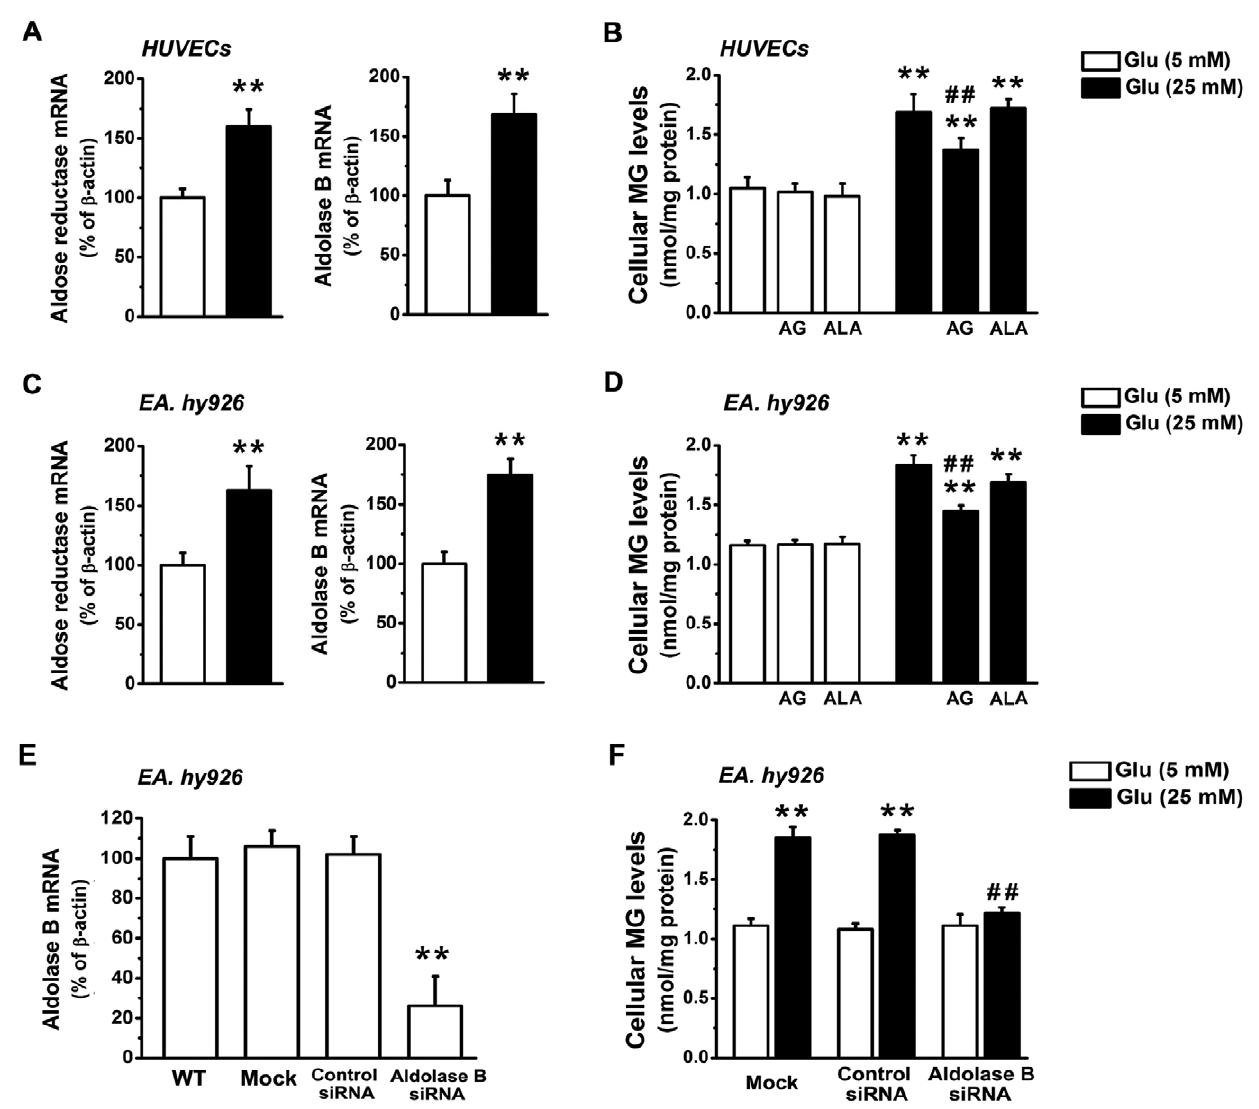
Figure 1. Knockdown of aldolase B prevented MG overproduction in high glucose-treated EA. hy926 cells. Real-time PCR analysis of aldose reductase and aldolase B expression (A, C) and MG levels (B, D) in human umbilical vein endothelial cells (HUVECs) (A, B) and EA. hy926 cells (C, D) treated with glucose (Glu) in the presence or absence of aminoguanidine (AG, 1 mM) and alagebrium (ALA, 100 m M) for 3 days. ** P , 0.01 vs . 5 mM glucose; ## P , 0.01 vs . 25 mM glucose. Levels of aldolase B mRNA (E) and levels of MG (F) in wide-type cells (WT) and cells transfected with control or aldolase B siRNA, or only transfection agent (Mock). ** P , 0.01 vs . 5 mM glucose; ## P , 0.01 vs . control siRNA.